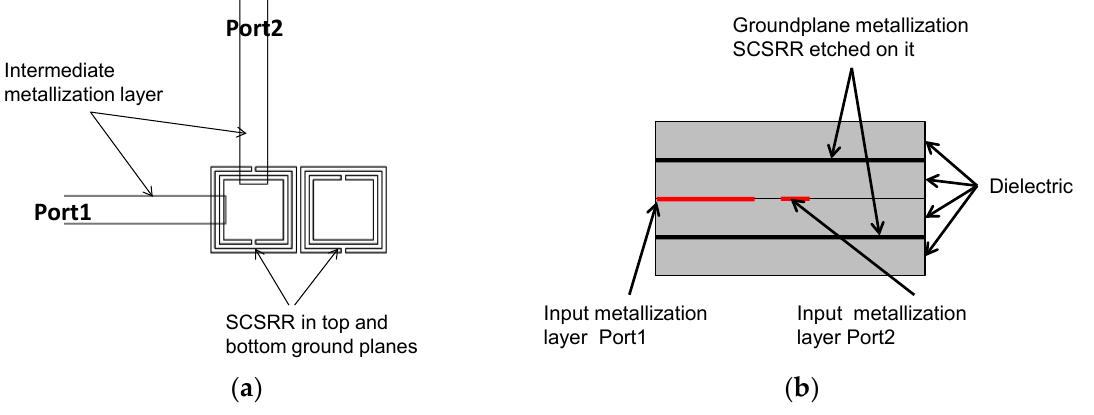
Figure 18. ( a ) Top view SCSRR multi-frequency side-by-side reverse resonator. ( b ) Front view of the stacked layer distribution.